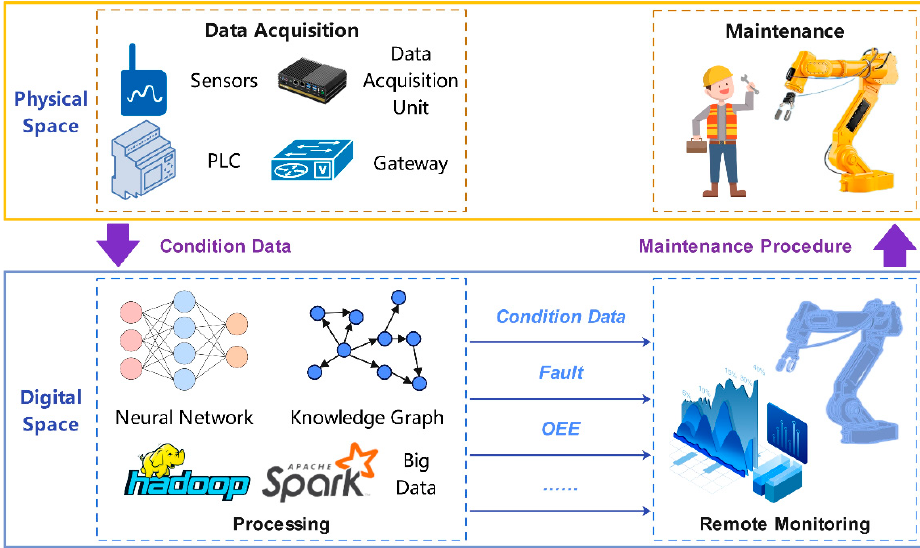
Figure 10. Digital